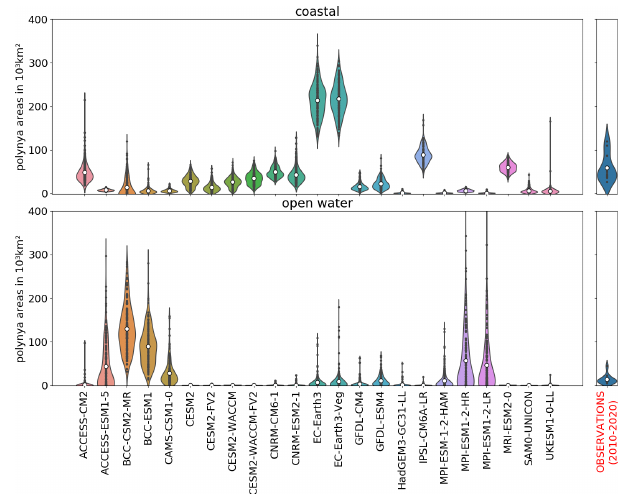
Figure 7. Mean total winter polynya area as determined from monthly sea ice thickness for the CMIP6 models and the observa- tional product (SMOS thin ice). For the models, results are shown for the full 165 years of the historical scenario, the observational data set includes the years 2010–2020. Each black dot is an average yearly polynya area for one model. The violin shape indicates the distribution of the values, the most values are in the thickest spot of the violins. The white dot indicates the mean value averaged over all available